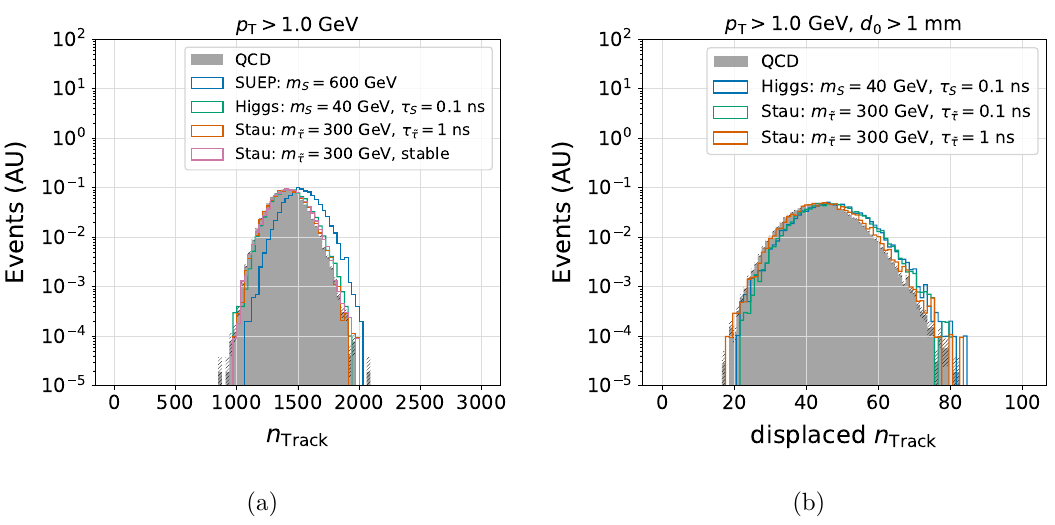
Figure 21. The total number of tracks per event(a) and total number of displaced tracks per event (b) for minimum bias QCD and representative signal samples at pile-up=200. Slashed bands on the QCD distribution represent the statistical